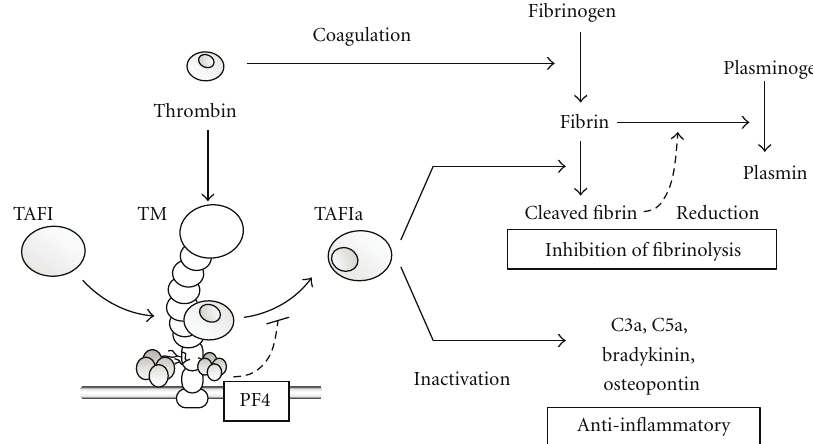
Figure 5: TAFIa-dependent modulation of inflammation and fibrinolysis. TAFIa appears to possess anti-inflammatory properties due to its ability to inactivate proinflammatory mediators, C3a, C5a, bradykinin, and osteopontin by removing their C-terminal residues. TAFIa also removes the C-terminal lysines of fibrin, leading to a reduction in the rates of plasmin generation and fibrinolysis. PF4 inhibits the activation of TAFI and enhances the activation of protein C by the TM-thrombin complex.